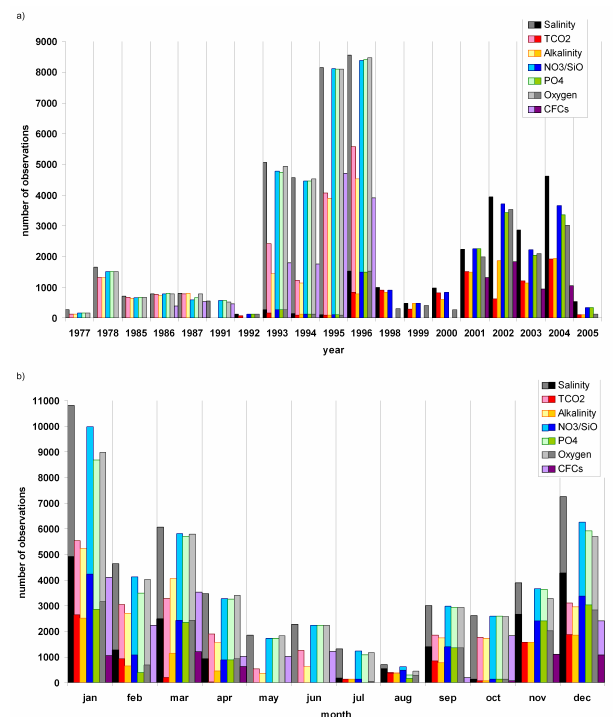
Figure 2. Temporal distribution of the measurements assembled in the Southern Indian dataset (a) by year and (b) by month. For each year or month color bars compare the number of observations for salinity, TCO 2 , alkalinity, nitrate / silicate, phosphate, oxygen and CFCs. CARINA data (bright colors) are distinguished from GLO- DAP data (light